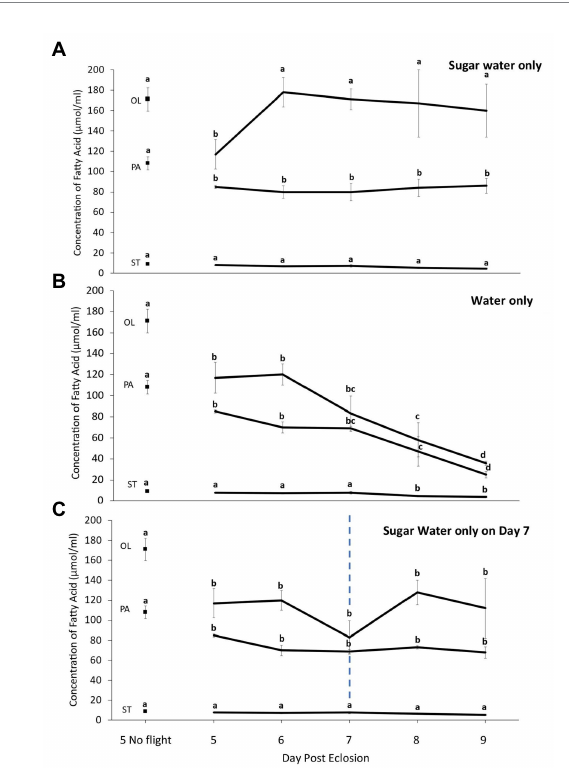
FIGURE 5 Change in the concentration of essential [linoleic (LA) and alpha linolenic (ALA)] fatty acids in the fat body of true armyworm moths reared under fall conditions as a function of the number of 8-h flight periods when fed (A) sugar water ad lib daily, (B) provided water only, or (C) provided water on all days except at the end of the flight period on Day 7 when they were provided sugar water ad lib during the rest period. The two values for Day 5 represent samples taken from un-flown moths prior to the flight period and from moths after 8 h of flight. In the other days samples were taken at the end of the flight period. Letters indicate statistically significant differences in each category of fatty acid (Tukey’s HSD, p < 0.05). N = 10 per sample group ( N = 20 in Day 5 no